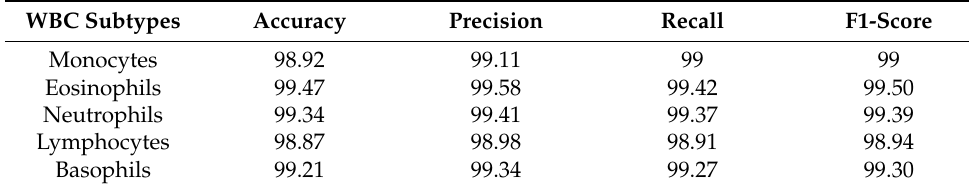
Table 4. Multi-class classification on the LISC